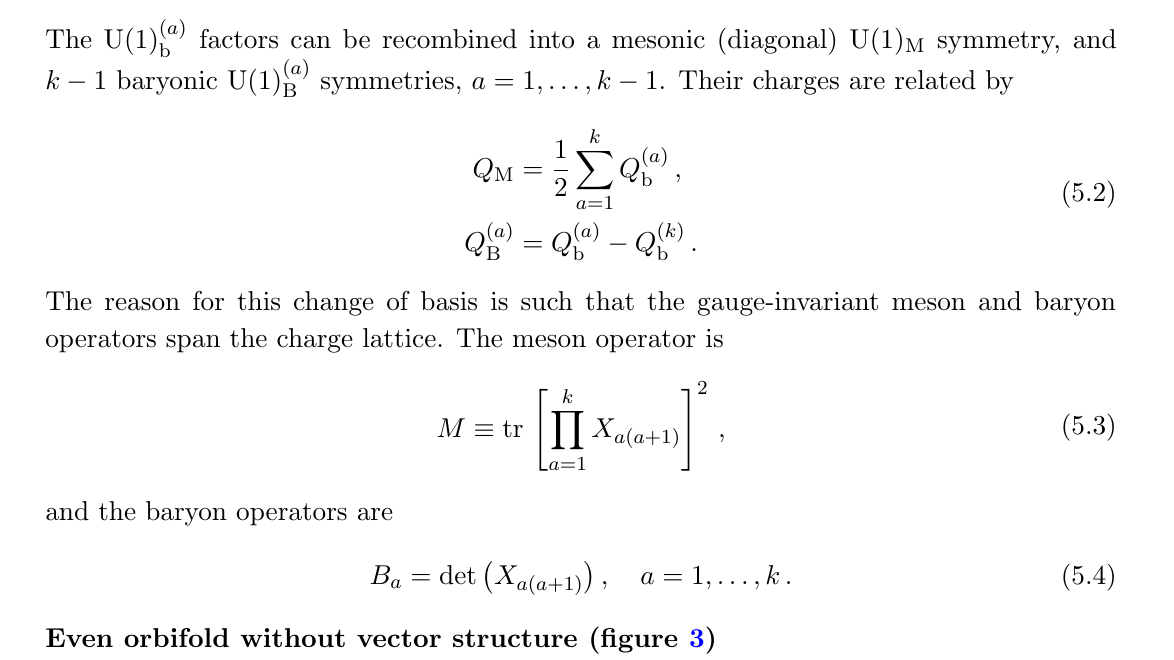
Figure 3 . Five-dimensional infrared quiver gauge theories giving rise to orbifold superconformal (cid:12)eld theories with even n = 2 k and without vector